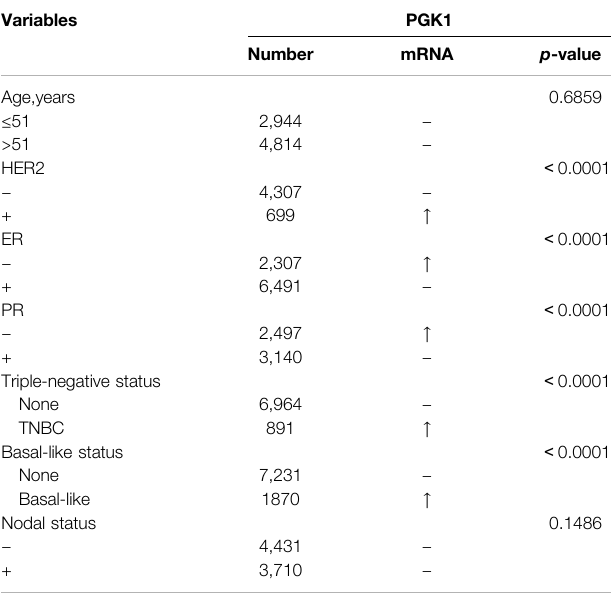
TABLE 3 | The correlation between PGK1 mRNA expression and the clinicopathological parameters of breast carcinoma.